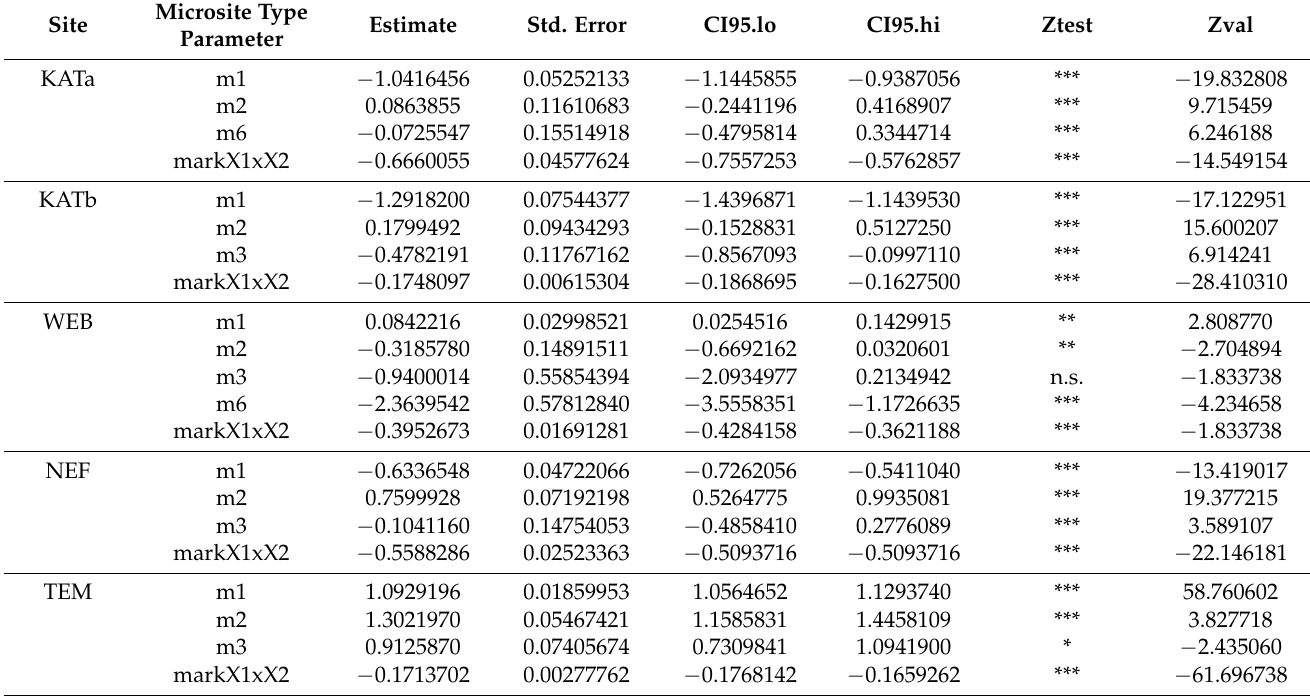
Table 9. Parameters of the calculated multitype Strauss hard-core process (MSH) (m—microsite, m1 (intercept)—stand conditions without scarification, m2—skid trail, m3—skid trail border, m4— hollows or furrows, m5—mounds, m6—stand edge, markX1xX2—interaction between overstorey pine trees and pine seedlings, signif. codes: 0 ‘***’, 0.001 ‘**’, 0.01 ‘*’, 0.1